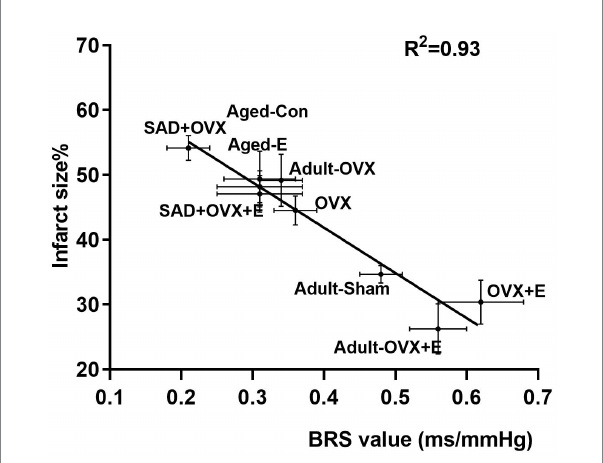
FIGURE 4 Baroflex sensitivity (BRS) value correlates with neuroprotection from ischemic injury. Measurements of BRS and ischemic cerebral damage in adult OVX and aged rats treated with vehicle or estrogen are shown is BRS as a function of the infarct size, measured by 2,3,5-TTC staining from corresponding brain samples derived from the same studies. Linear regression yielded a high inverse correlation of R 2 =